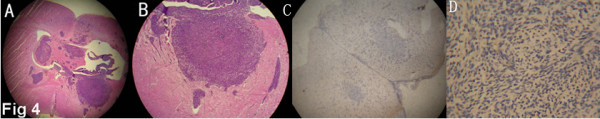
Pathological examination of intracranial tumor mass in NC nude mice. A, SU-1 cells produced relatively well-delimited tumor masses (HE × 20). B, local amplification of A, showing nodular tumor formation (HE × 100). C, SU-2 cells behaved more aggressively (HE × 20). D, SU-2 cells infiltrated remoter regions and invaded the whole brain evenly and densely (HE × 200).